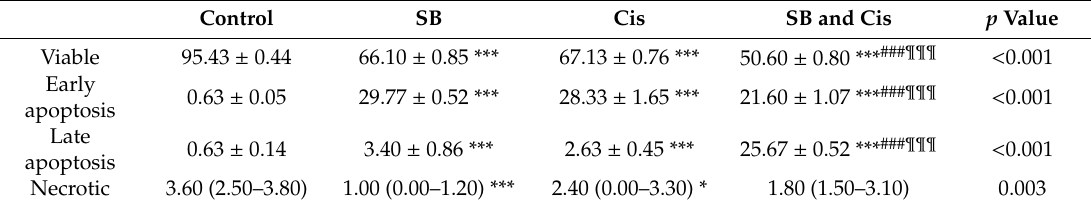
Table 1. Statistical analysis of annexin positive staining detected by flow cytometry in